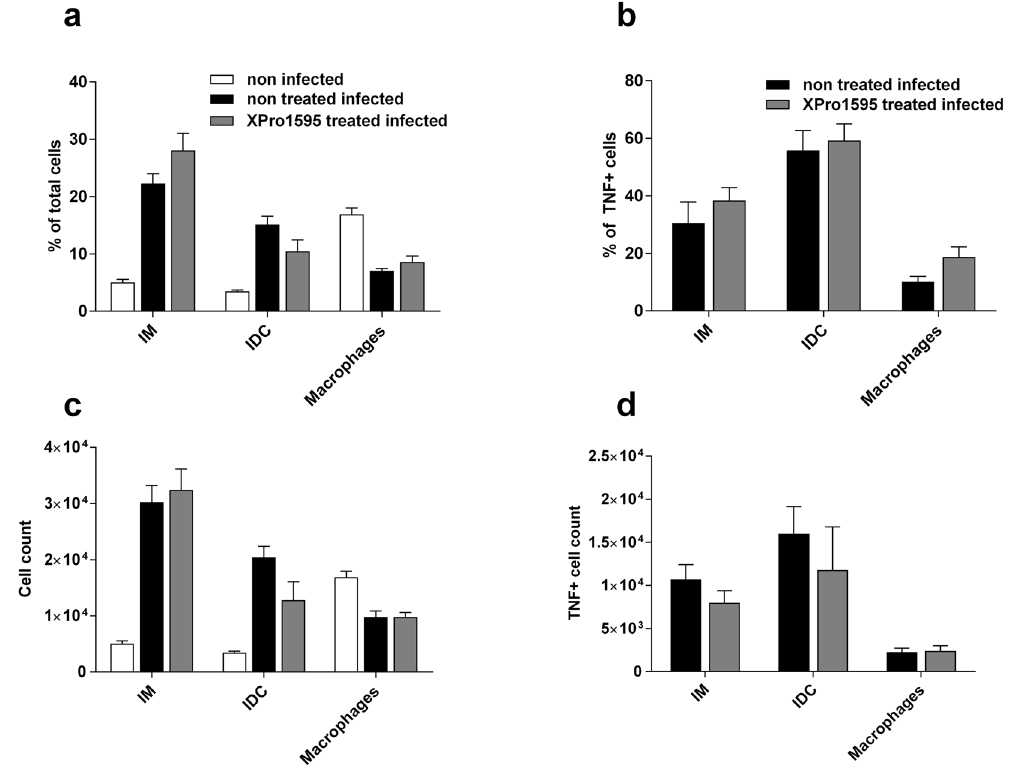
Figure 5. FACS analysis of liver mononuclear myeloid cells subpopulations. FACS analysis of live non- parenchymal liver cells isolated from C57Bl/6 mice at day 5 post T. brucei infection after treatment or not with 10 mg/kg XPro1595. Cells were gated and assayed for co-expression of CD11b, CD11c, Ly6C and TNF. (a) Percentage of liver CD11b + mononuclear myeloid cells subpopulations consisting of Ly6C + CD11c − inflammatory monocytes (IM), Ly6C + CD11c + inflammatory dendritic cells (IDC), and the Ly6C − macrophage; (b) Percentage of TNF producing mononuclear myeloid cells in each subpopulation. (c) cell count within total CD45 + liver non-parenchymal cells. (d) cell count within total CD45 + liver non-parenchymal TNF producing mononuclear cells. All graphs are mean ± SEM, n =